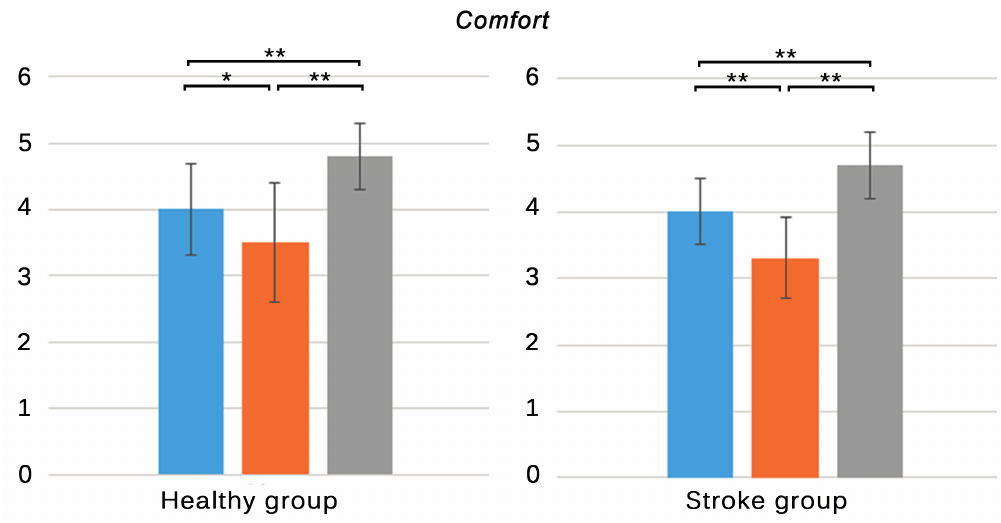
Figure 5. Subjective responses of healthy subjects and individuals with stroke to item five of questionnaire A. Blue : NaturalPoint ® OptiTrack TM ; Orange : Polhemus TM G4 TM ; Grey : Microsoft ® Kinect TM . Only significant differences are stated. * p < 0.05, ** p <